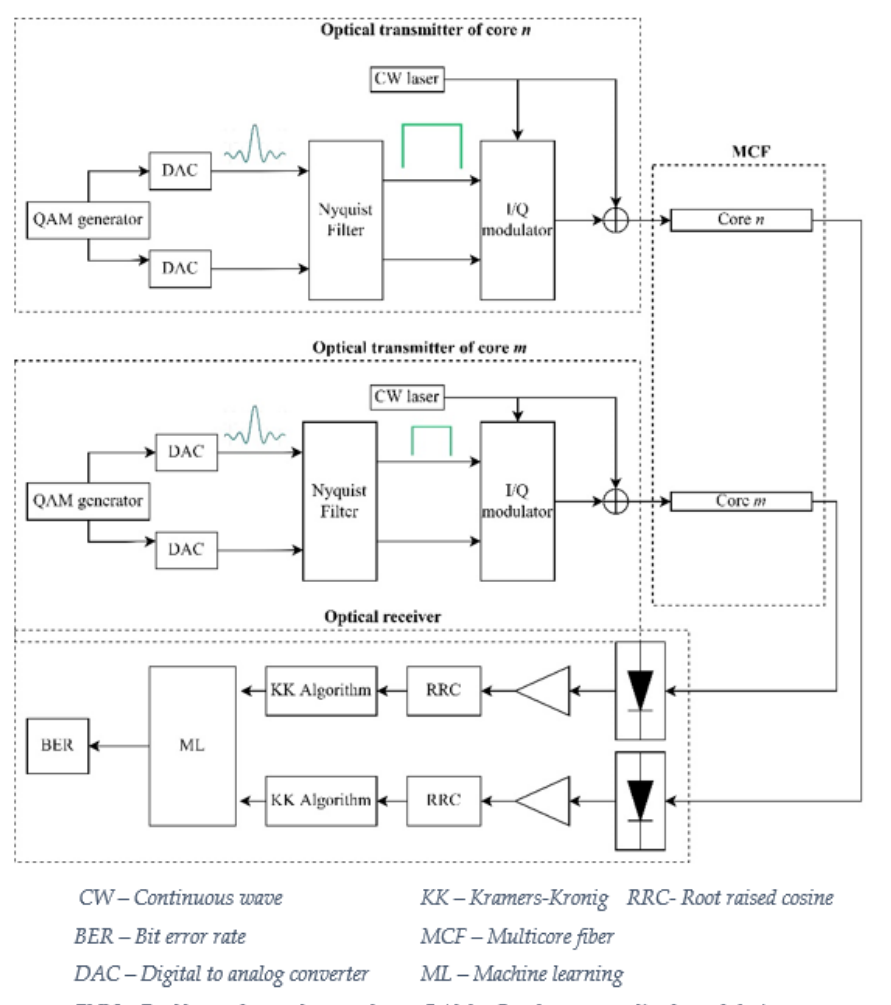
Figure 1. Schematic diagram of the short-reach MCF based system employing KK receivers.